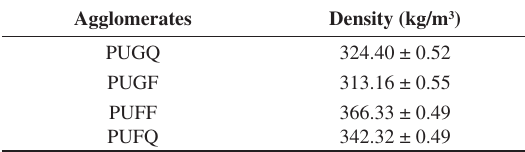
Table 1. Bulk density of the PUs agglomerates.